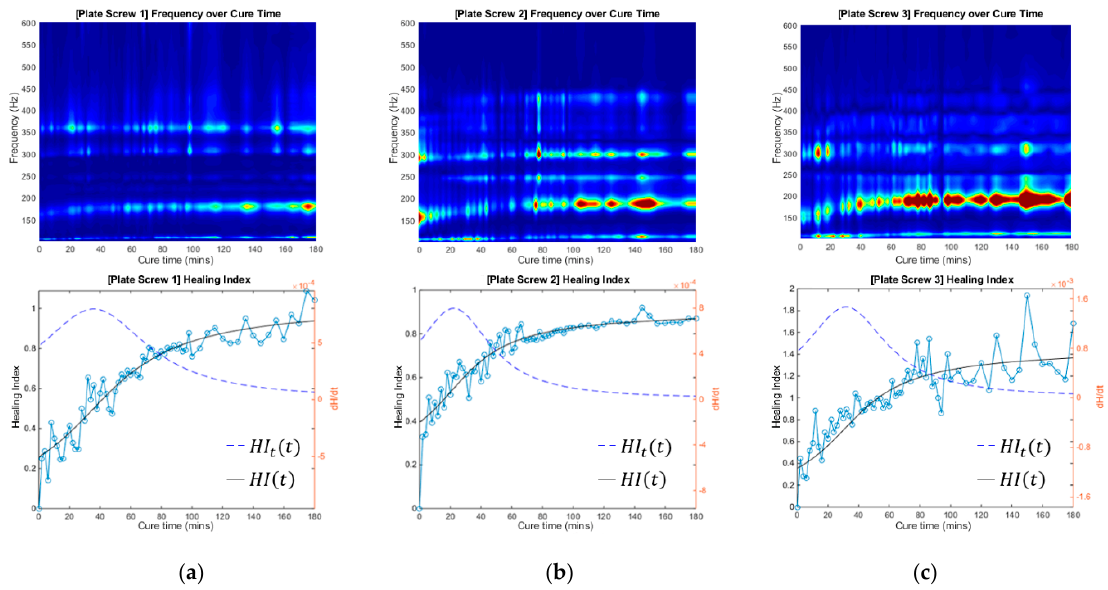
Figure 11. Frequency over cure time and Healing Index of three experimental investigations with mass damping. ( a ) Test #1; ( b ) Test #2; ( c ) Test #3.